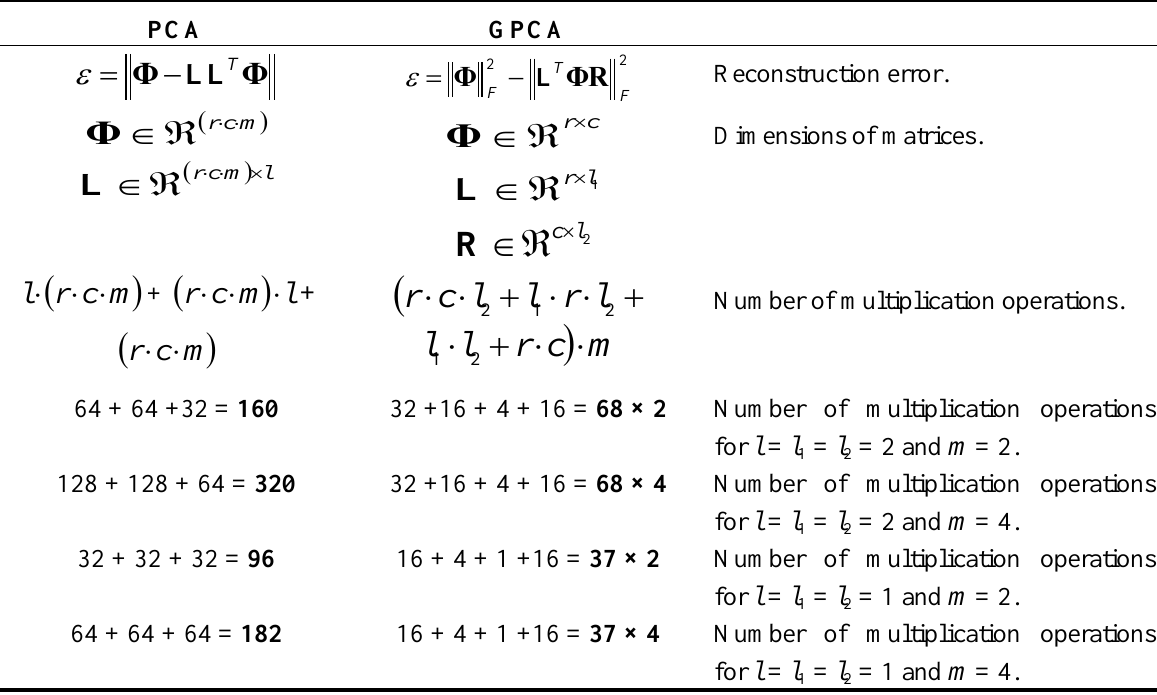
Table 1. Number of multiplications for PCA and GPCA, using different numbers of emitters and